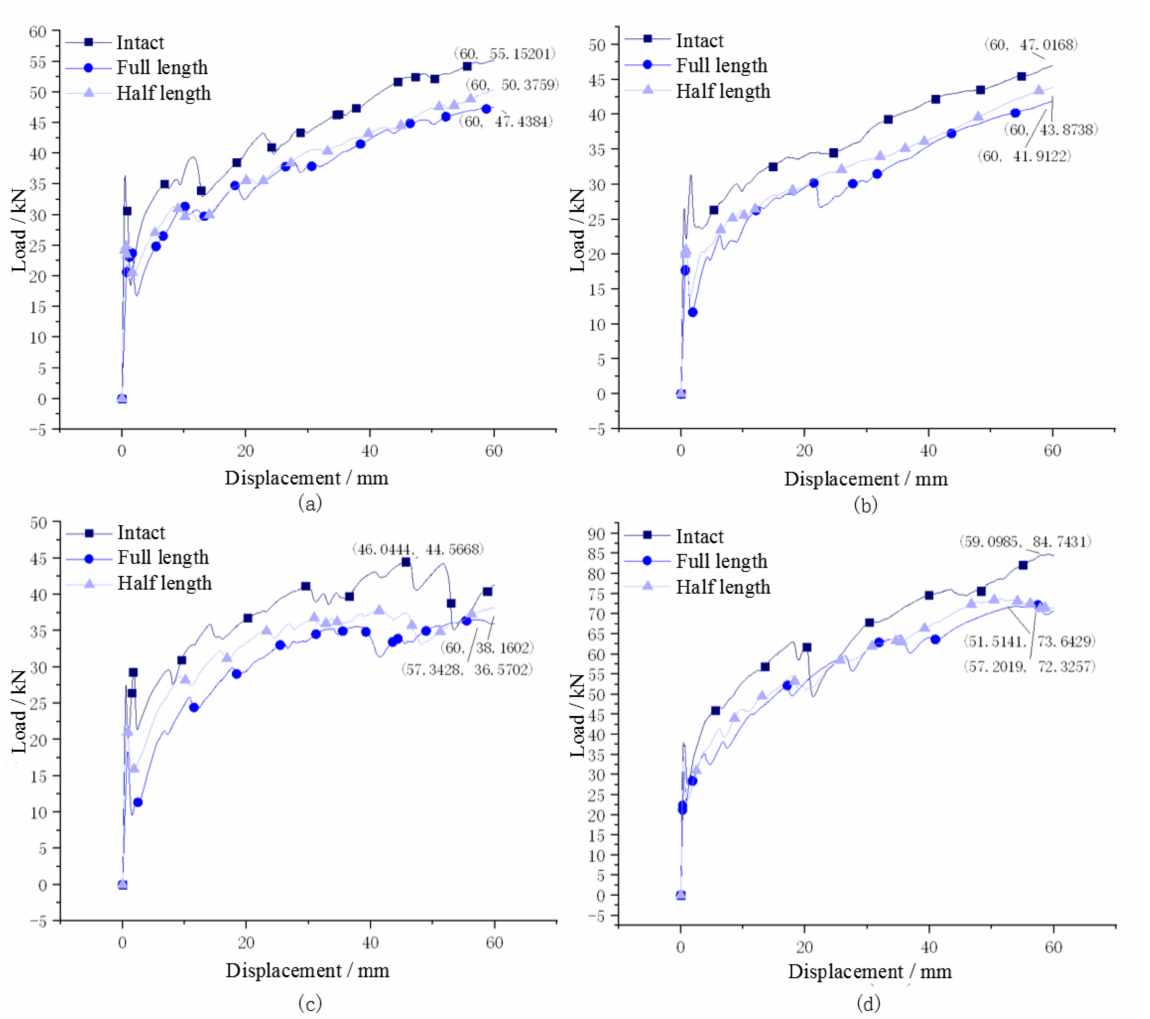
Figure 8. Effect of crack length on ( a ) circular; ( b ) rectangular; ( c ) arched; and ( d ) trenched cable